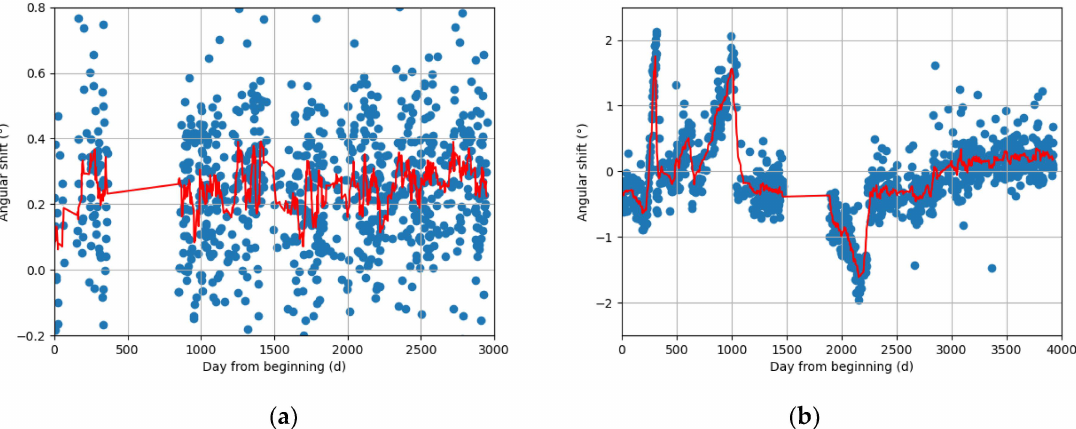
Figure 5. Angular error at sunset caused by the time shift evaluated from the difference of the sky brightness at sunset and at dawn, ( a ) at Pennar and ( b ) at